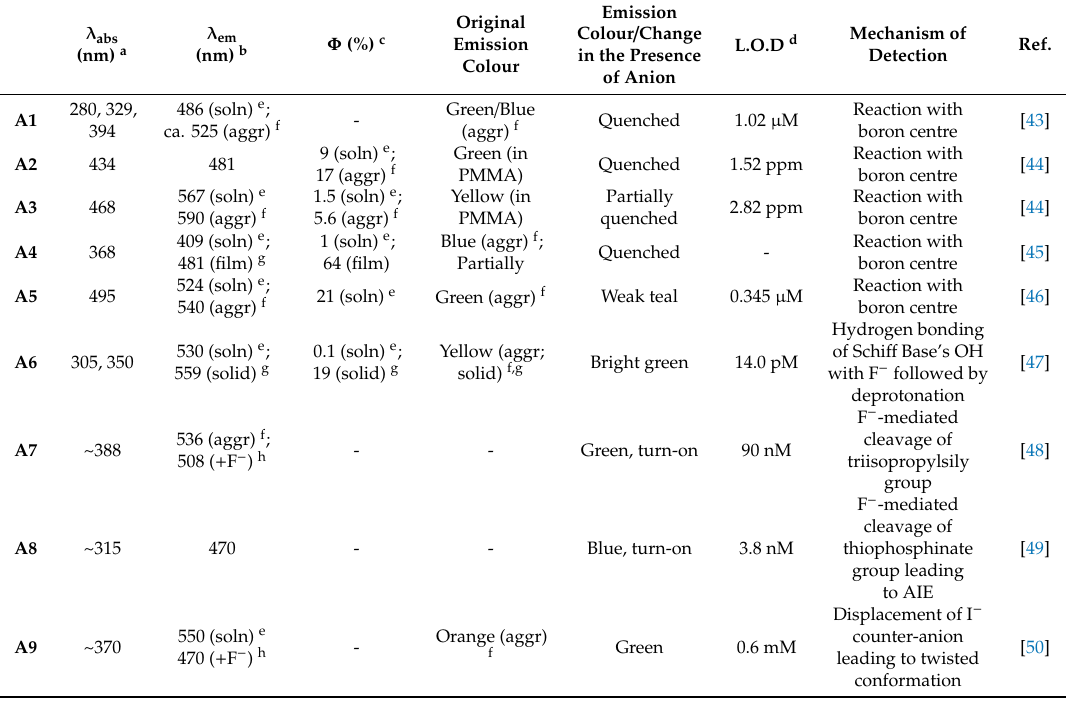
mechanisms shown. Table 1. Summary of optical properties and sensing performance of AIE-based fluoride chemosensors A1 – A13 .